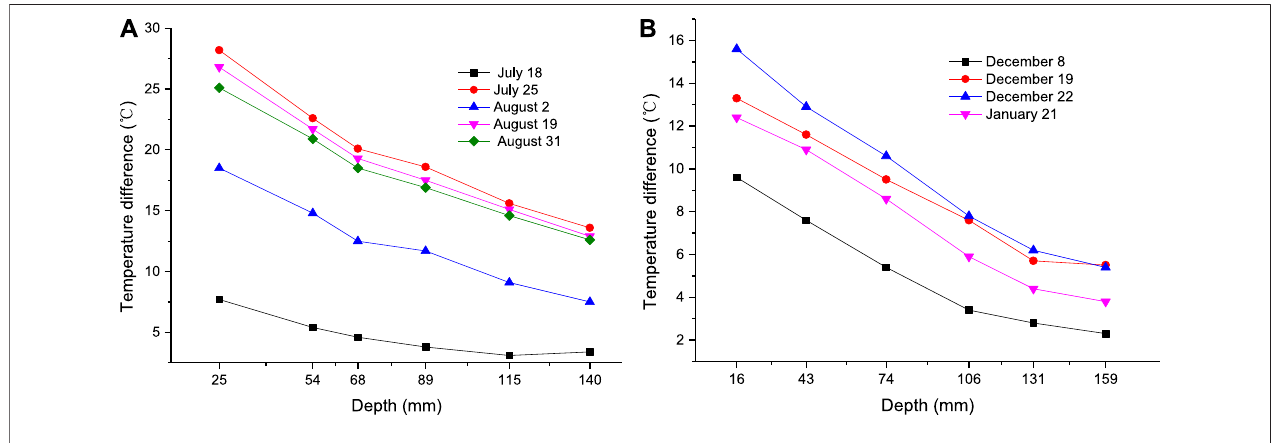
FIGURE 11 | Temperature distribution of asphalt pavement.